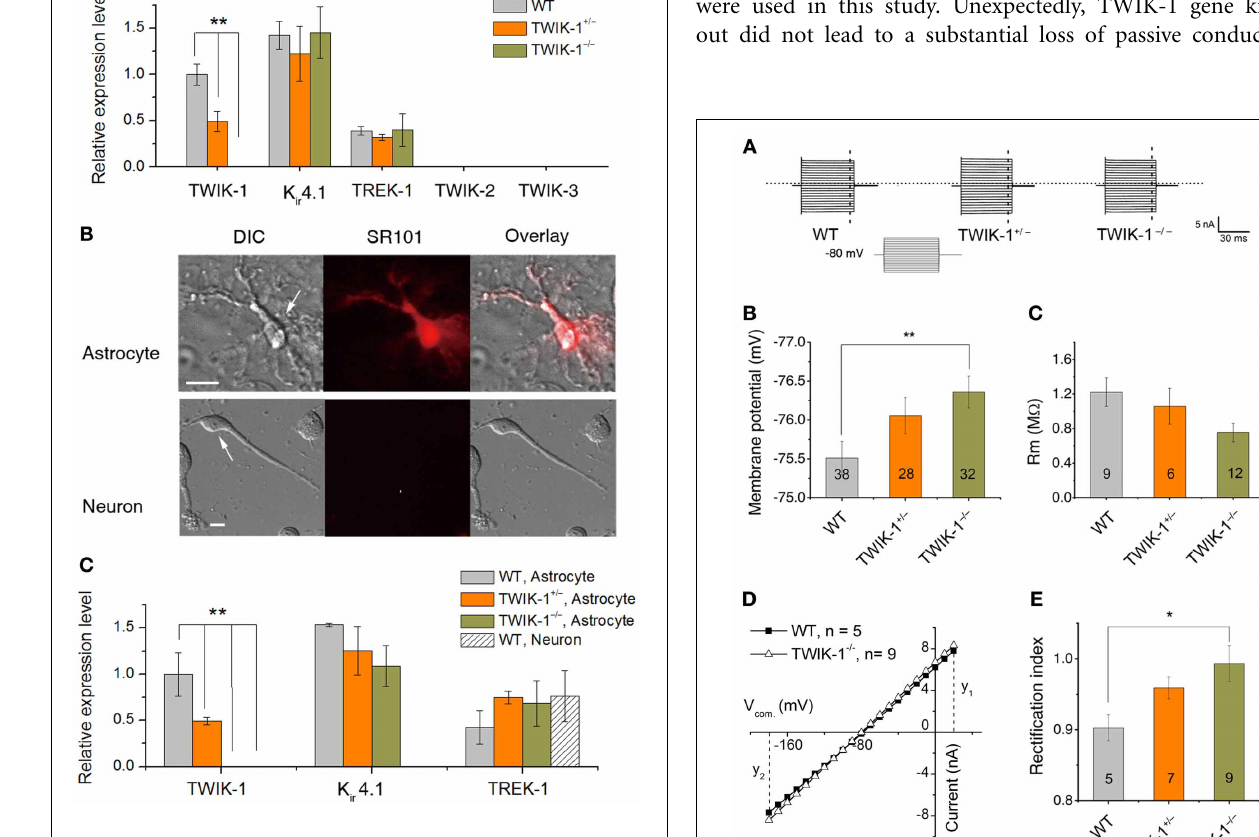
FIGURE 2 | TWIK-1 deletion does not alter the expression pattern of astrocyte K + channels. (A) qRT-PCR results of the relative quantity of TWIK-1, K ir 4.1, TREK-1, TWIK-2, and TWIK-3 from the total mRNA isolated from mice hippocampus. The expression levels of TWIK-1 mRNAs were reduced to half and hundred percent in TWIK-1 + / − and TWIK-1 − / − mice, respectively. (B) Morphology of freshly isolated astrocyte and neuron from mice hippocampus (DIC). Scale bar: 10 μ m. These cells were harvested separately for qRT-PCR analysis. Astrocytes were selected based on their positive SR101 staining (middle up panel), and SR101 staining was completely devoid in isolated pyramidal neurons (middle bottom panel). (C) The expression pattern of TWIK-1, K ir 4.1 and TREK-1 of isolated astrocytes resembled that of the hippocampal tissues (A) . The expression of TWIK-1 and K ir 4.1 appeared to be astrocytic, while TREK-1 was both astrocytic and neuronal. Data were normalized to the expression level of TWIK-1 mRNA in WT. In each genotype group, 30 isolated astrocytes or neurons were harvested from 3 different mice and analyzed separately to obtain a mean ± SEM ( n = 3). ∗∗ P < 0 . 01.